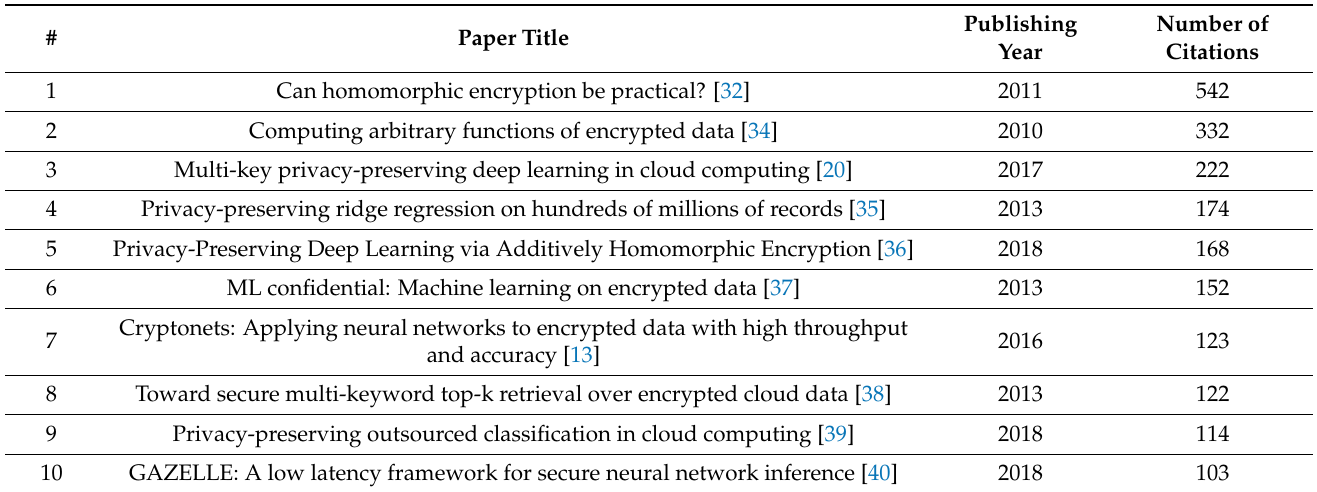
Table 4. Top 10 papers cited in total.